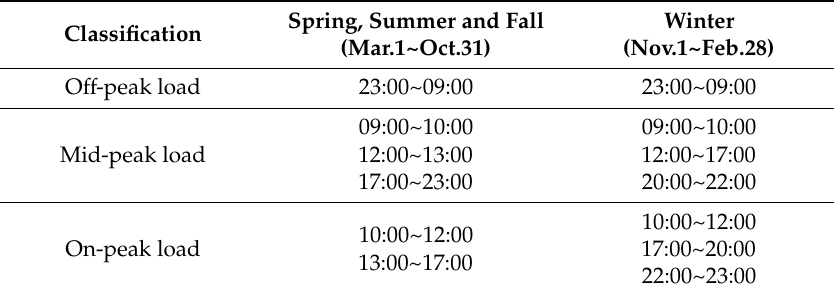
Table 1. Daily TOU rate schedules